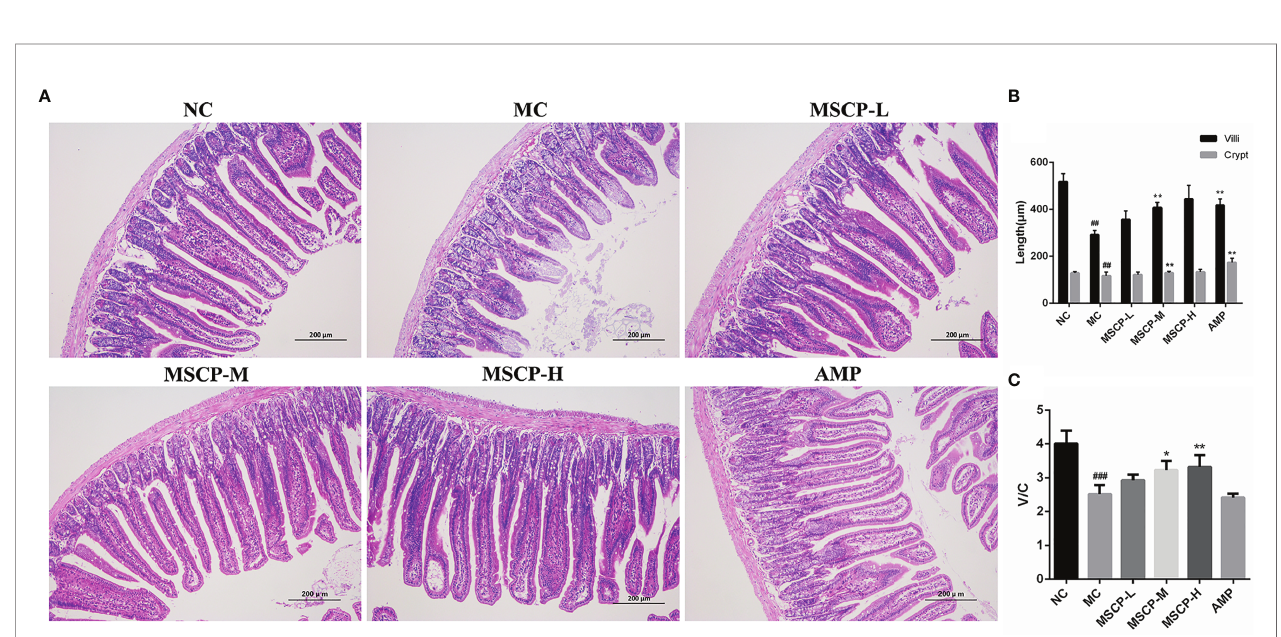
FIGURE 7 | Effects of MSCP administration on the intestinal mucosal morphology in CTX-treated mice. (A) Hematoxylin-eosin staining of jejunum section (100 ×, Scale bar = 200 mm). (B) The villus height and crypt depth. (C) The ratio of villus height to crypt depth. Data are expressed as mean ± SD. ## p < 0.01, ### p < 0.001 compared with NC group; * p < 0.05, ** p < 0.01, compared with MC